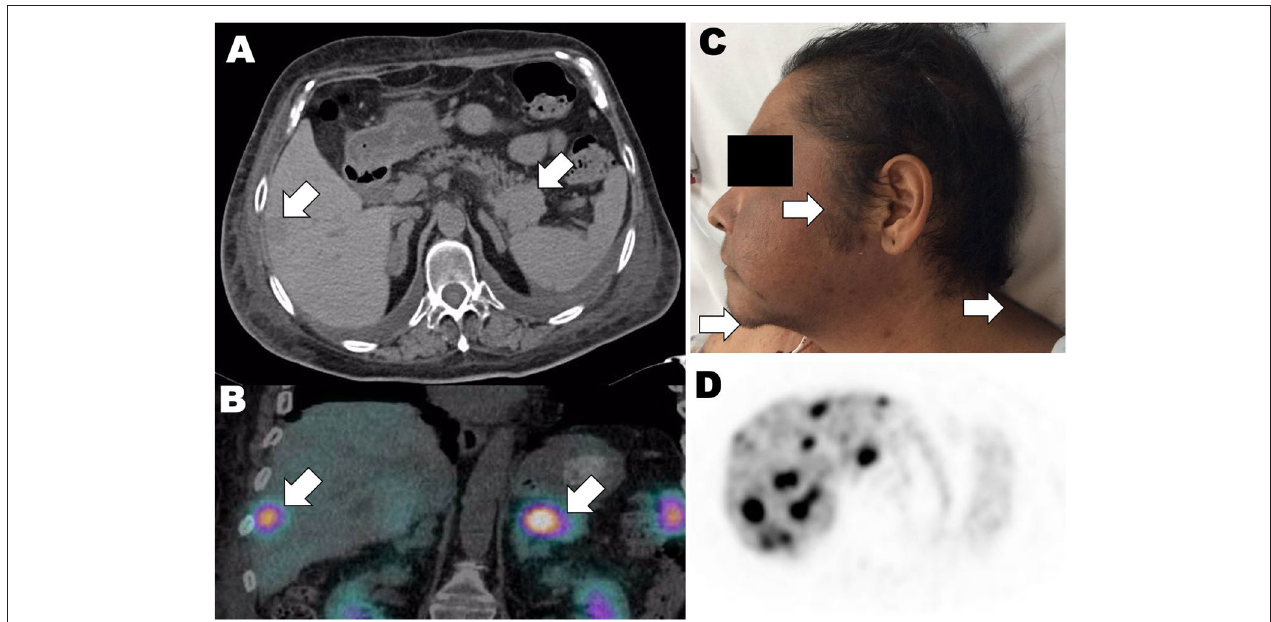
FIGURE 1 | (A) Computerized tomography showing neuroendocrine tumor at the pancreatic tail causing liver metastases (white arrows). (B) Octreotide-single-photon emission computerized tomography (SPECT) study showing hepatic and pancreatic focal lesions with enhanced uptake (white arrows). (C) Clinical picture of the patient remarking the skin hirsutism (white arrows), and hyperpigmentation. (D) 18-Fluorodeoxyglucose (18-FDG) positron emission tomography-computerized tomography (PET-CT) 18 months after diagnosis with persistence of tumor liver metastases (black